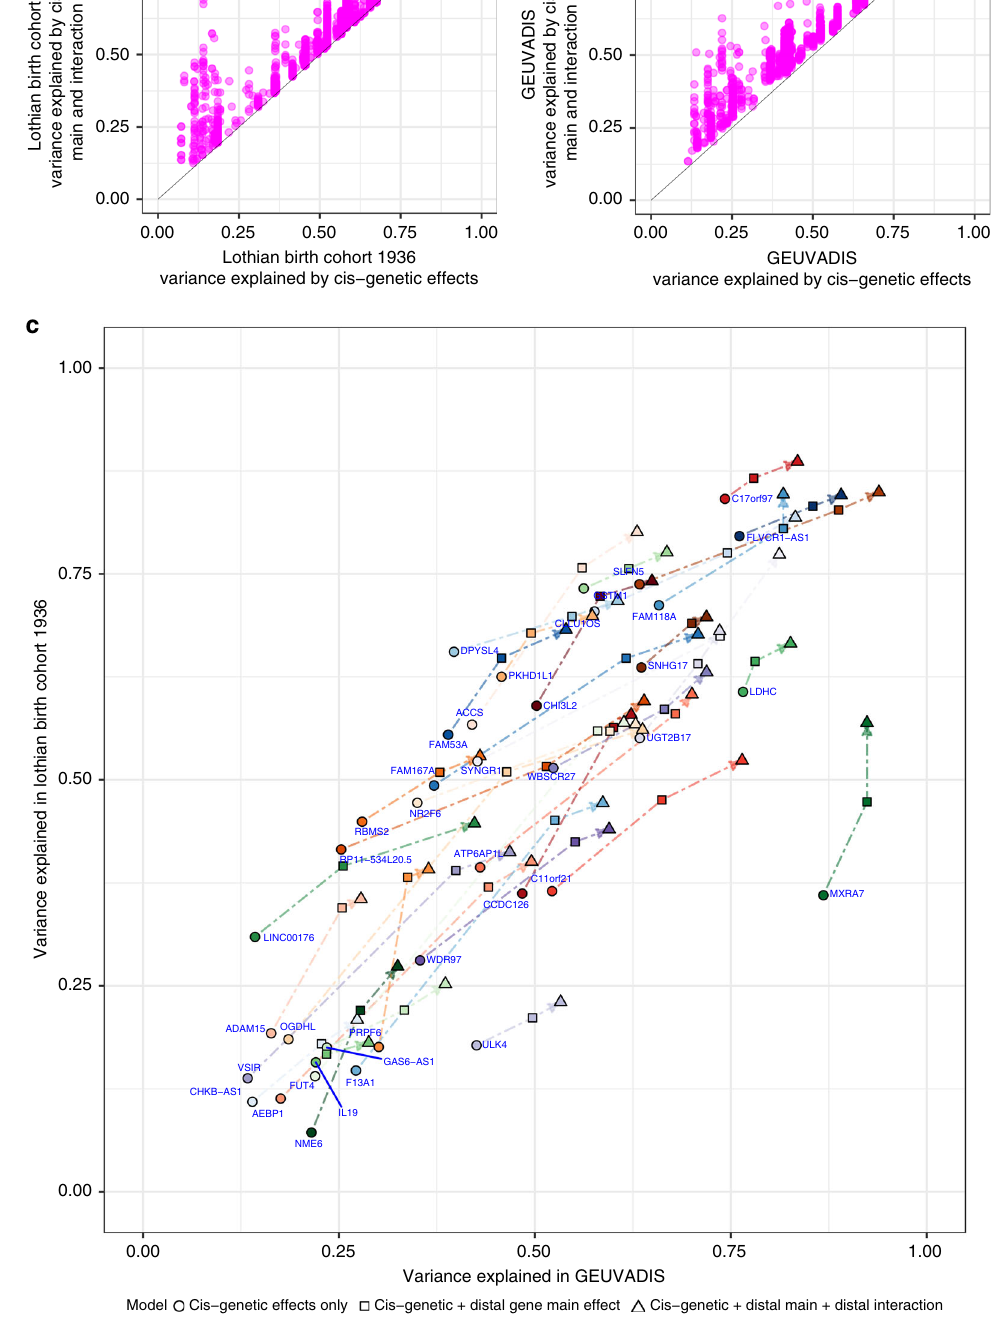
Fig. 7 The proportion of variance explained by additive and interaction effects between cis-regulatory variants and the expression of distal genes. A given interaction explains on average a an additional 0.68% of the variation in the gene ’ s expression in the Lothian Birth Cohort, and b an additional 2.0% in the GEUVADIS dataset. c The total set of non-redundant interacting genes identi fi ed by stepwise regression explained 13.2% of the variation in gene expression in the Lothian Birth Cohort and 17.6% in the GEUVADIS dataset, with the interaction effects alone explaining 2 and 5% of the variation on average respectively (points are coloured by gene